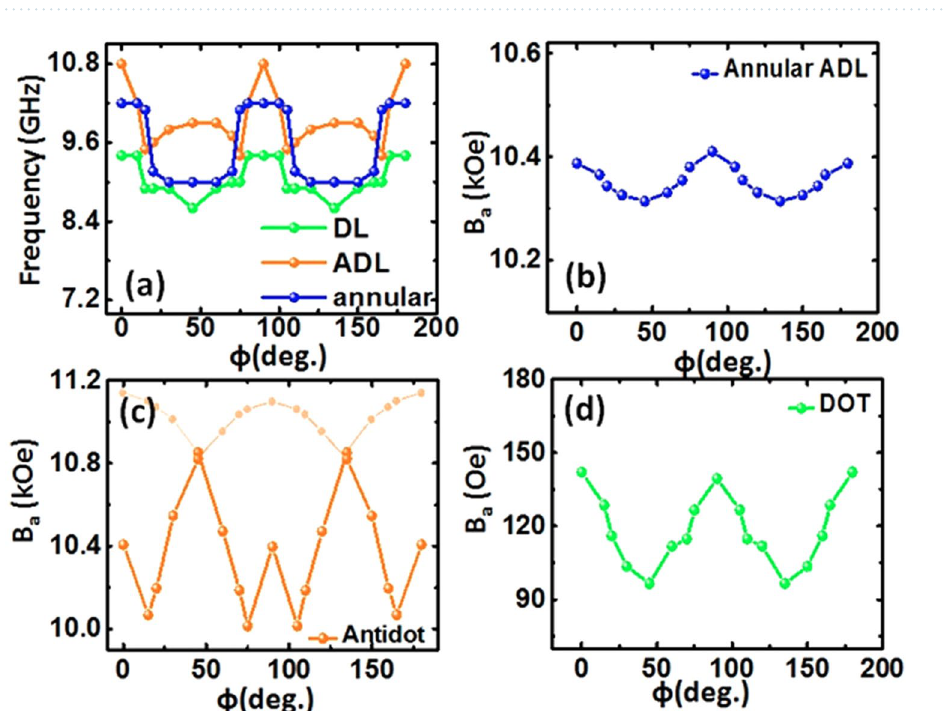
Figure 7. ( a ) Variation of SW frequency of mode 2 of the annular antidot lattice, only DL and only ADL with the in-plane angle of the bias field varying from 0° to 180° at a fixed H = 1080 Oe for comparison. The internal magnetic field of annular antidot lattice ( b ), only antidot ( c ) and only dot (d) with the in-plane angle of the bias field varying from 0° to 180° at a fixed H = 1080